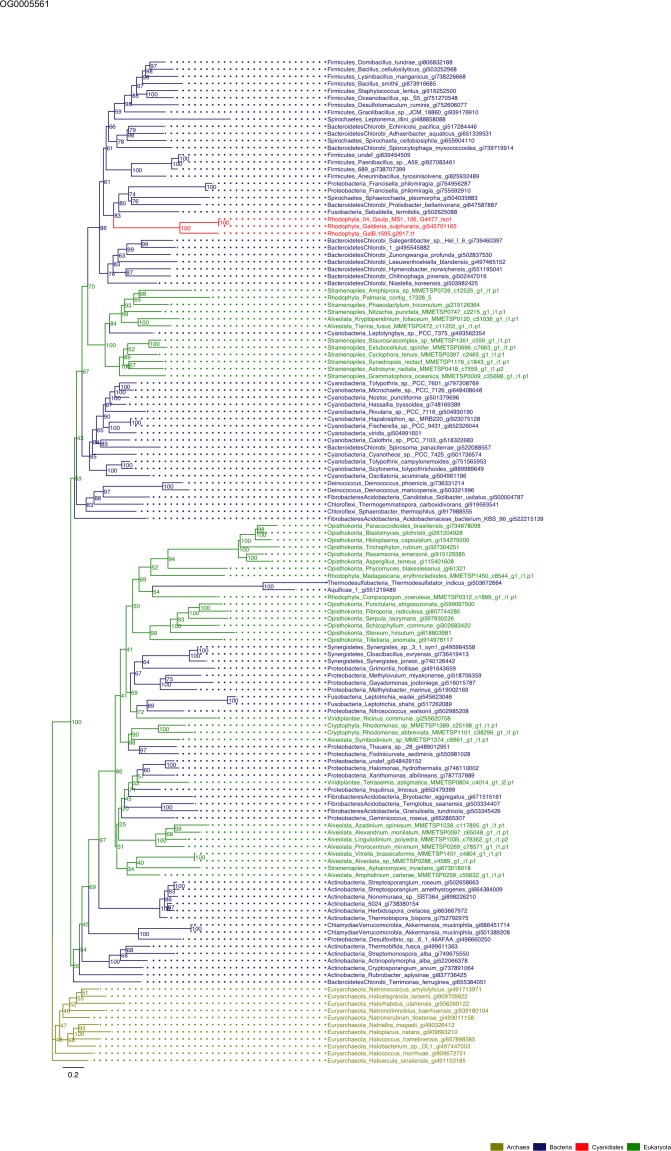
Sequence tree of orthogroup OG0005561.The tree is based on amino acid sequences. Archaea (yellow), Bacteria (blue), Cyanidiales (red), Eukaryotes including other red algae (green). Branches containing Cyanidiales sequences are highlited in red.